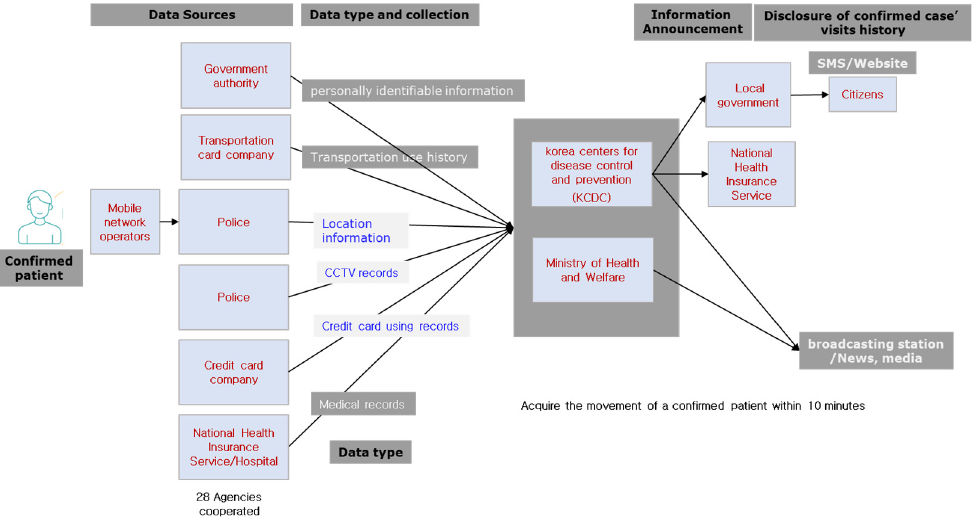
Figure 2. An example of the overall structure of the Korean contact tracing system [25].